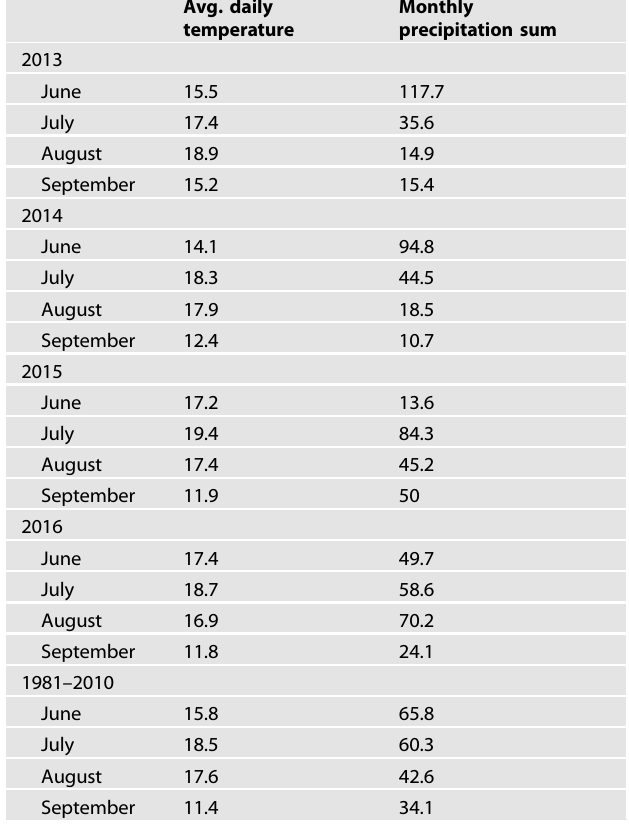
Table 1. Average daily temperature and total precipitation for